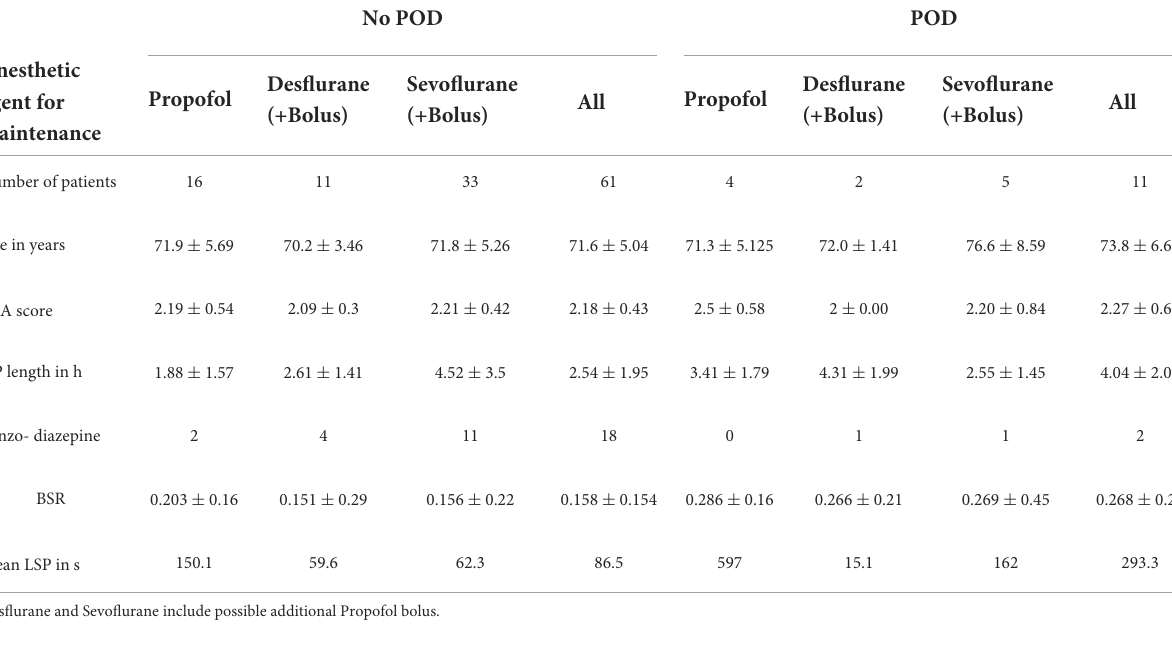
TABLE 2 Overview data BioCog.